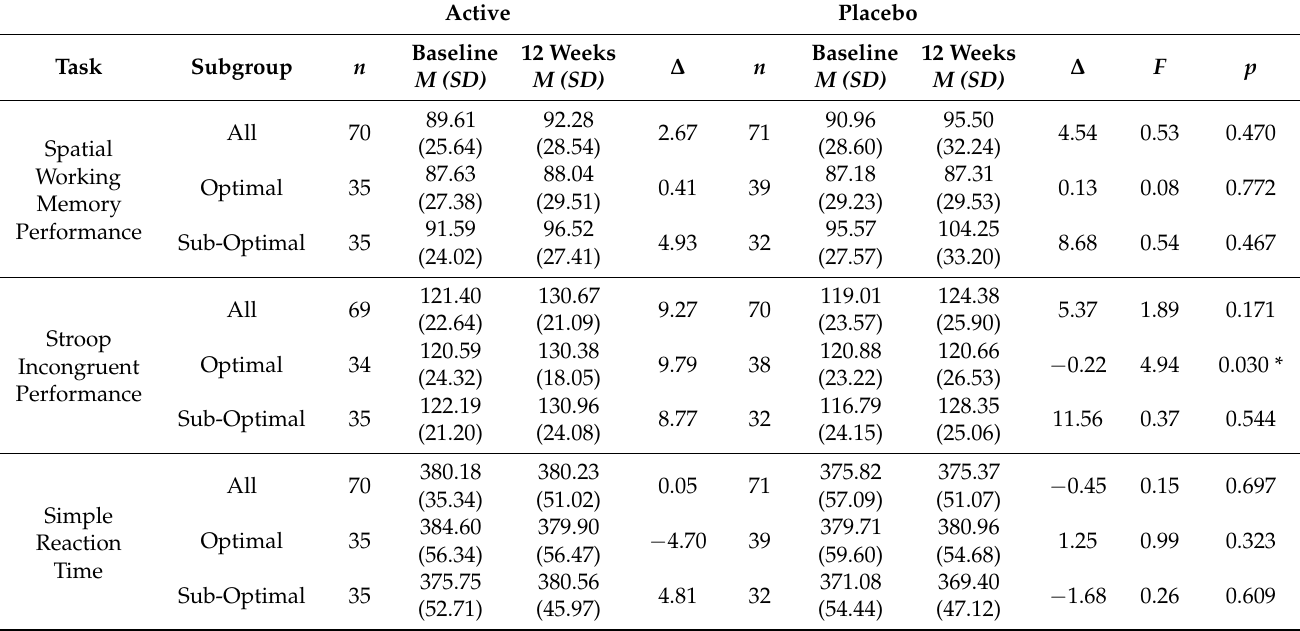
Table 2. Means, standard deviations, F value for treatment by time interaction and significance values from MMRMA analysis for cognitive outcomes at baseline and 12 weeks for active and placebo